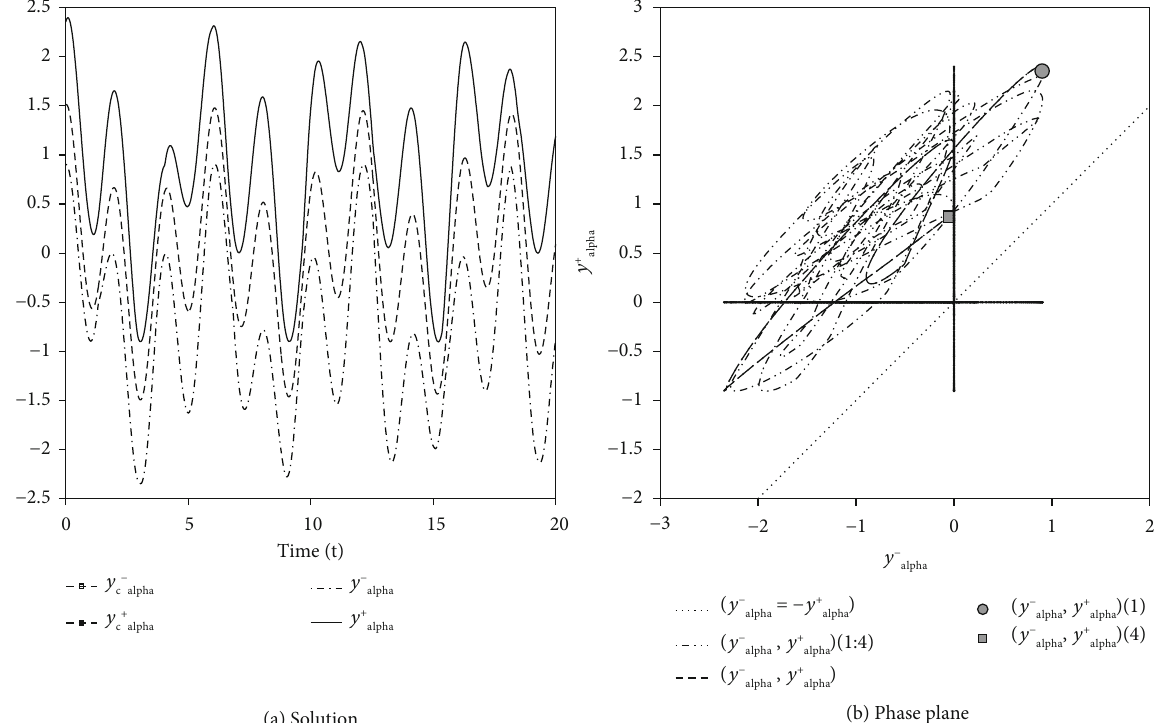
− + , y + y , y c c α α (cid:2) and the ½ α α (cid:2) , with the parameters as in Equation (33). (b)